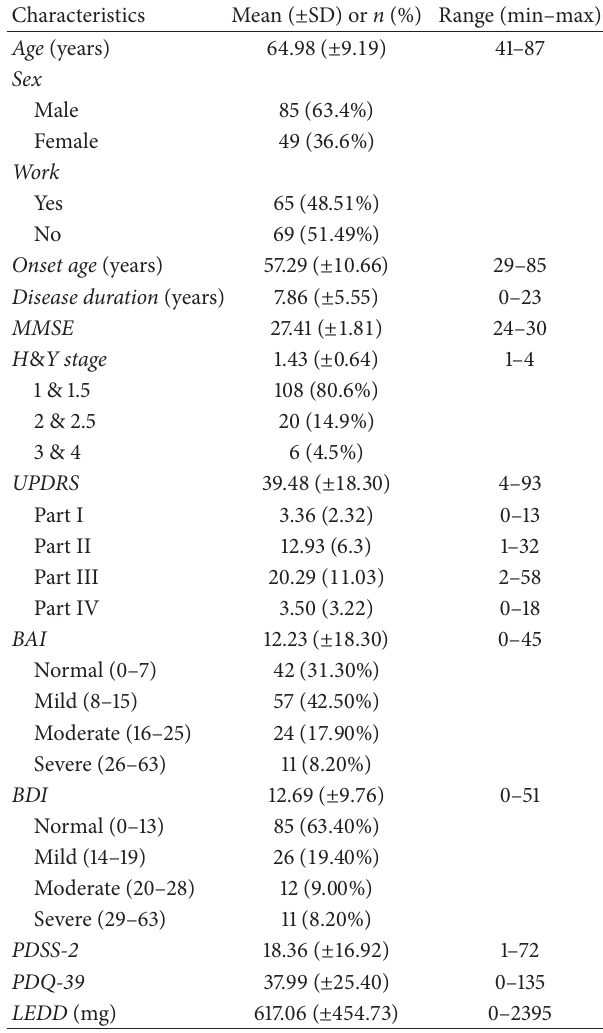
Table 1: Characteristics of the participants (𝑁 = 134)